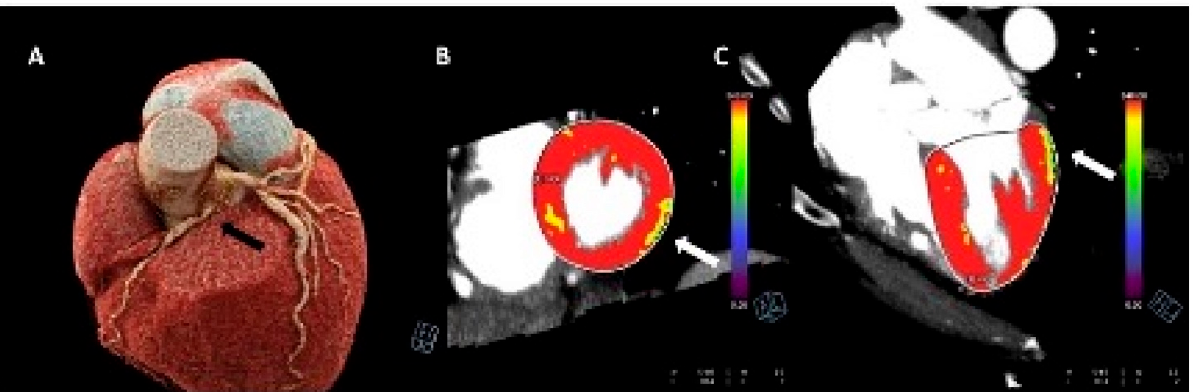
Figure 4. Stress-computed tomography perfusion imaging of a 15-year-old boy with an anomalous origin of the right coronary artery from the left sinus of valsalva. The black arrow indicates the coronary artery abnormality (Panel ( A )). The images with arrows ( B , C ) indicate stress-induced perfusion defects of the infero-lateral wall of the left ventricle.